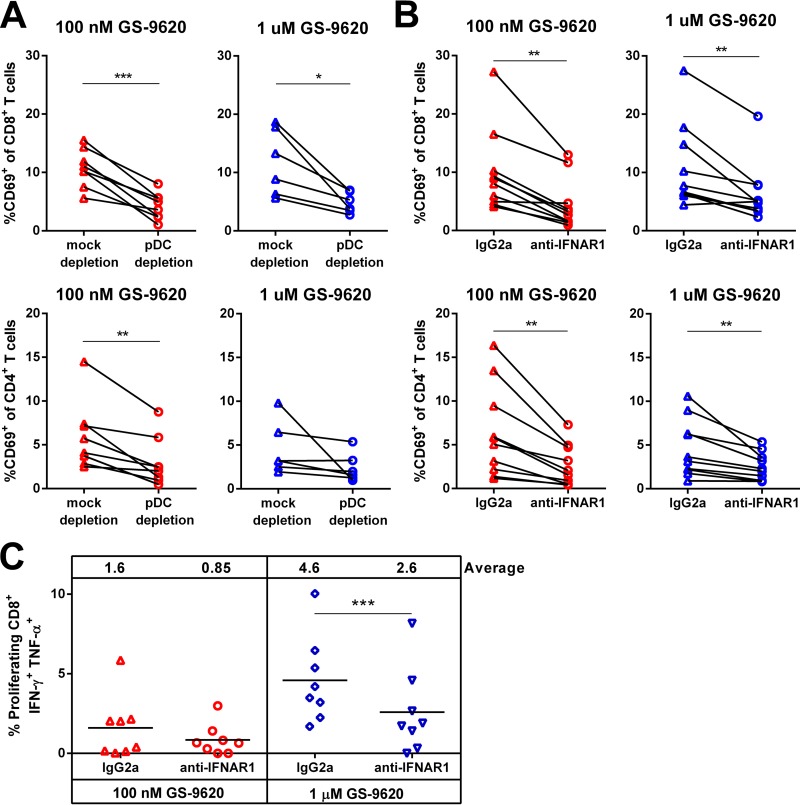
pDCs and type I IFNs are required for T cell activation by GS-9620. (A and B) PBMCs isolated from ART-suppressed HIV-infected individuals and stimulated with GS-9620 were depleted of pDCs prior to stimulation (A) or treated with anti-IFNAR1 at the time of stimulation where noted (B). Flow cytometry was used to measure CD69 levels in CD8+ T cells and CD4+ T cells 48 h after GS-9620 treatment. (C) CFSE-labeled PBMCs were stimulated with a pool of HIV peptides (Gag, Pol, Env, and Nef) with or without GS-9620 for 8 days. The cells were restimulated with HIV peptides and stained for intracellular cytokines. The horizontal bars and the numbers at the top of each graph indicate the average percentages of IFN-γ+ TNF-α+ cells among proliferating cells, with each symbol representing a PBMC sample from a single donor. The P values were determined by paired Student t tests. *, P < 0.05; **, P < 0.01; ***, P < 0.001.